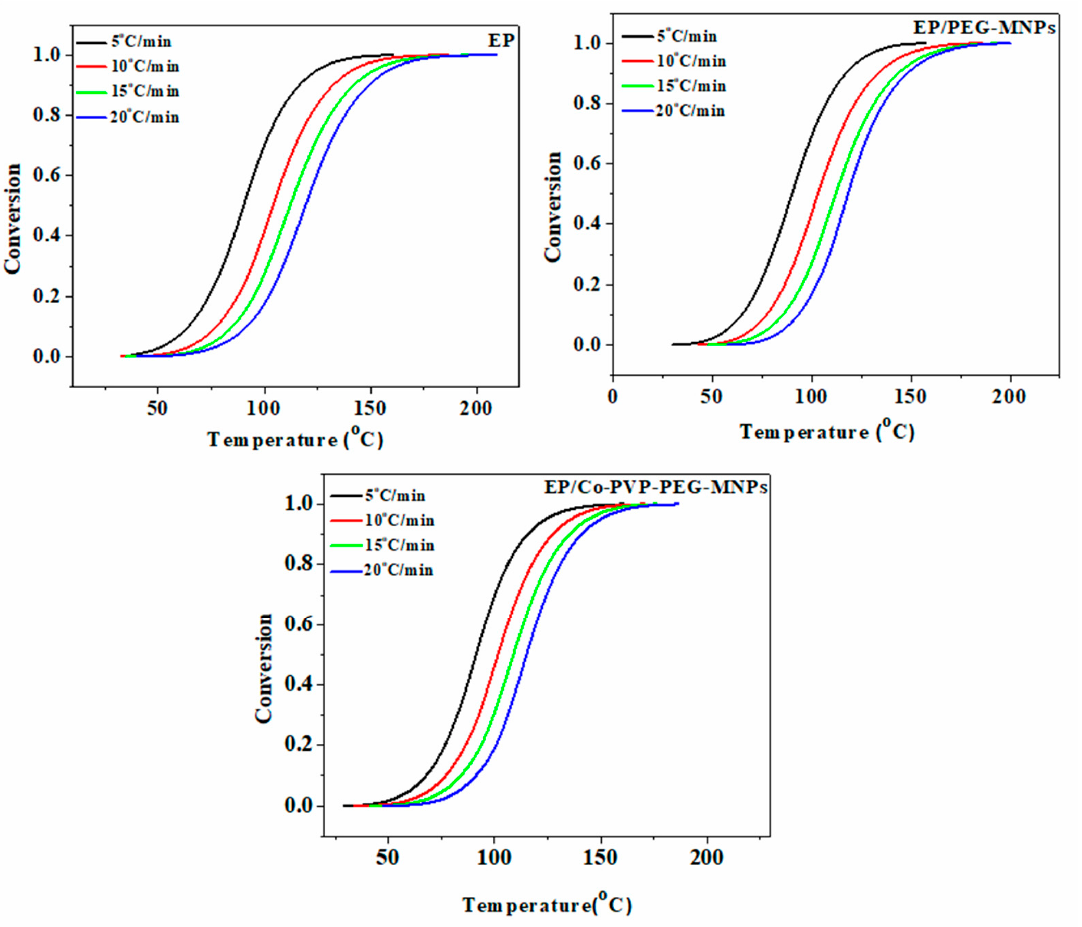
Figure 9. The variation of α in terms of reaction temperature for the neat resin, EP (the reference sample) and EP/PEG-MNPs and EP/Co-PEG-MNPs nanocomposites as a function of heating rate (5, 10, 15 and 20 °C·min − 1